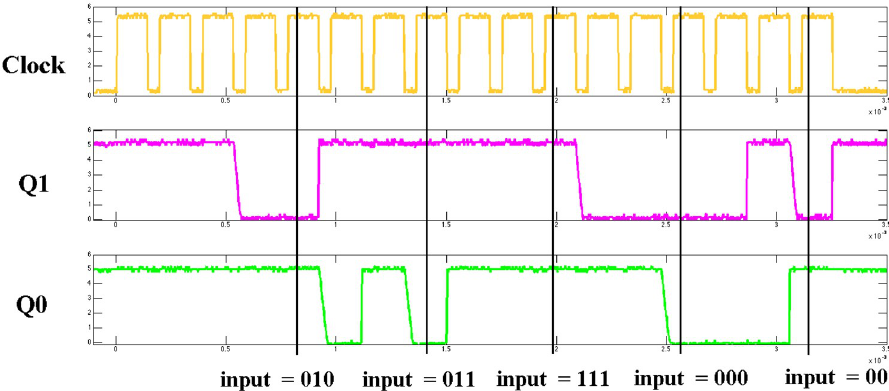
Fig 7. Observed output waveforms from NLDBM hardware. The hardware calculates Hamming weights of five different inputs.